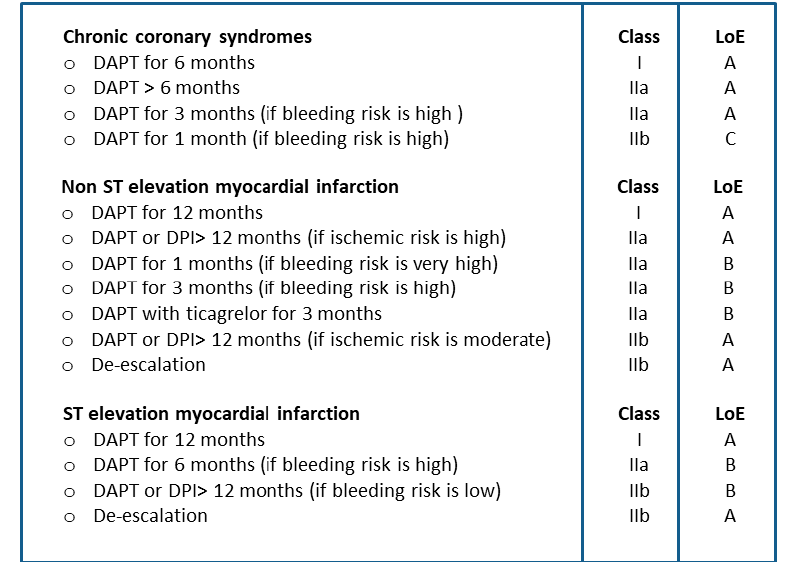
Figure 1. Current recommendations of the European Society of Cardiology about the strategies for antiplatelet treatment after percutaneous coronary intervention. DAPT: dual antiplatelet therapy; DPI: dual pathway inhibition; LoE: level of evidence.